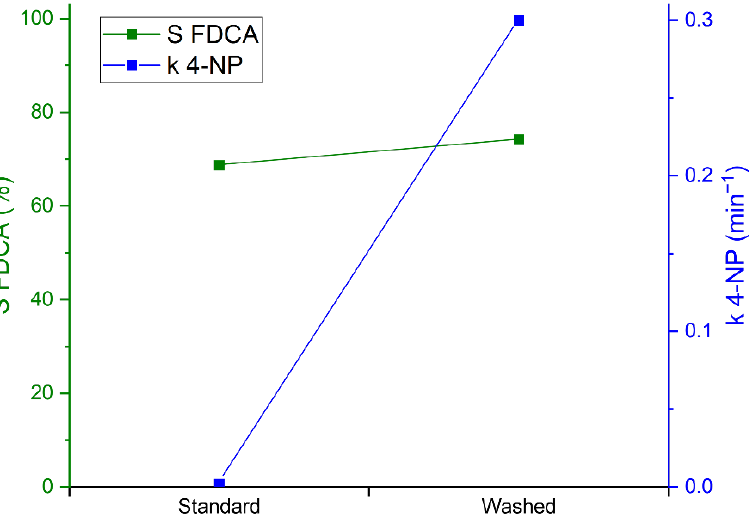
Figure 9. Comparison of the catalytic performances of standard and washed catalysts (HD = 99%) in terms of FDCA selectivity (in green) and 4-NP reduction apparent kinetic constant (in blue).